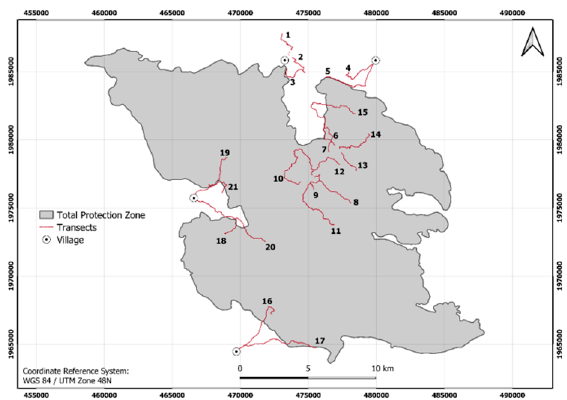
Figure 2. Map of the study area, including the 21 transects that were walked at the four sectors (Konglor-Natan, Konlgor, Buamlou and Kuankacha) of the Phou Hin Poun National Protected Area, Laos.